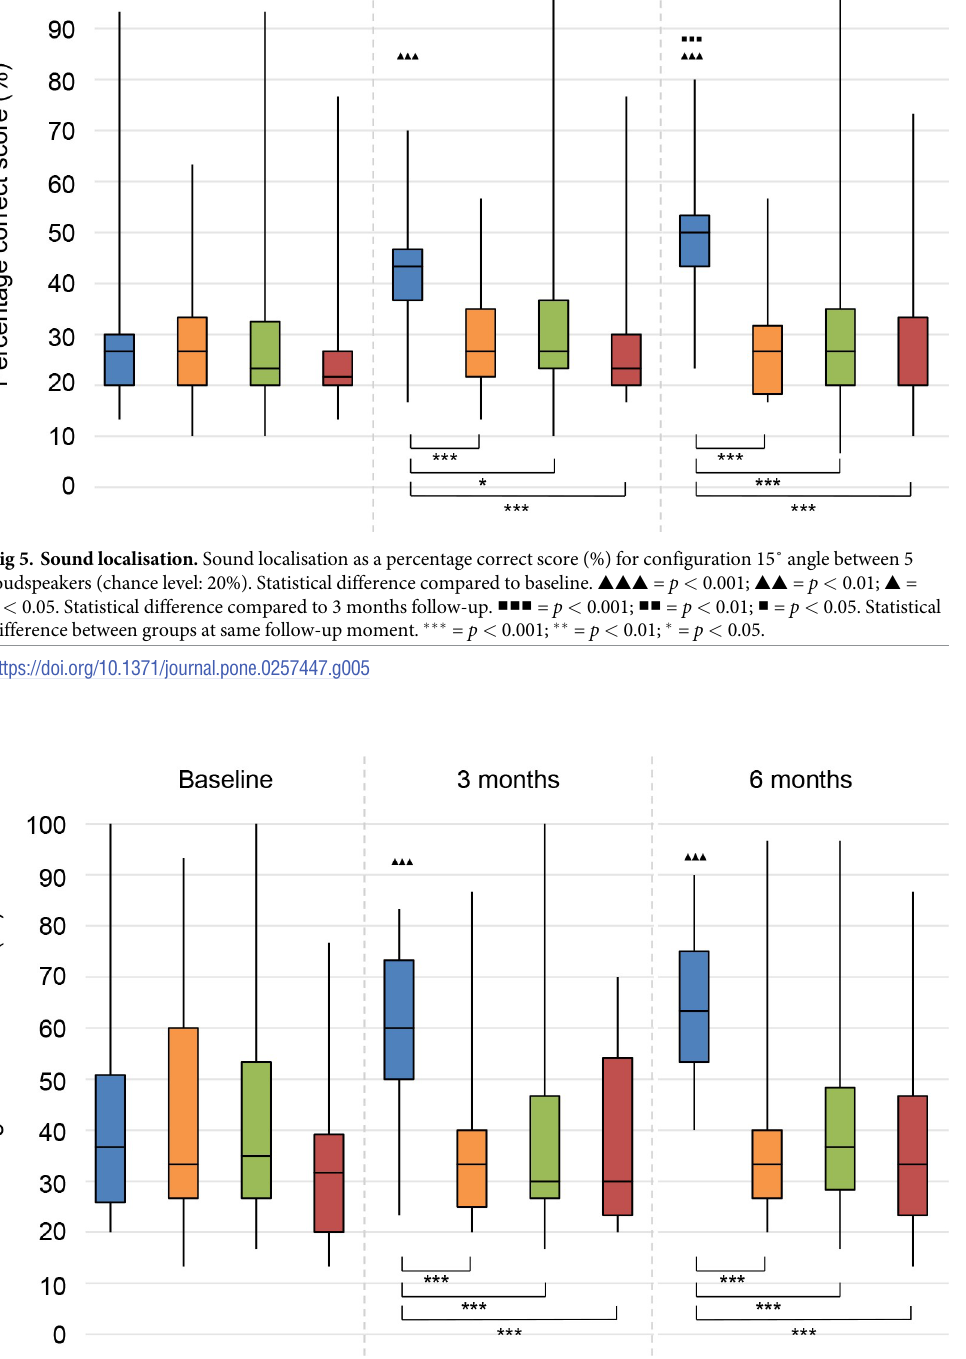
Fig 6. Sound localisation. Sound localisation as a percentage correct score (%) for configuration 30˚ angle between 5 loudspeakers (chance level: 20%), Statistical difference compared to baseline. ▲▲▲ = p < 0.001; ▲▲ = p < 0.01; ▲ = p < 0.05. Statistical difference compared to 3 months follow-up. ■■■ = p < 0.001; ■■ = p < 0.01; ■ = p < 0.05. Statistical difference between groups at same follow-up moment. ��� = p < 0.001; �� = p < 0.01; � = p < 0.05.